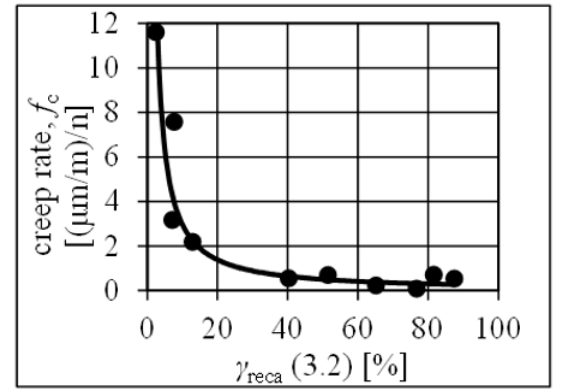
Figure 4. Relationship between creep rate of AC 16 asphalt mixes and averagere recoverable strain of different binders